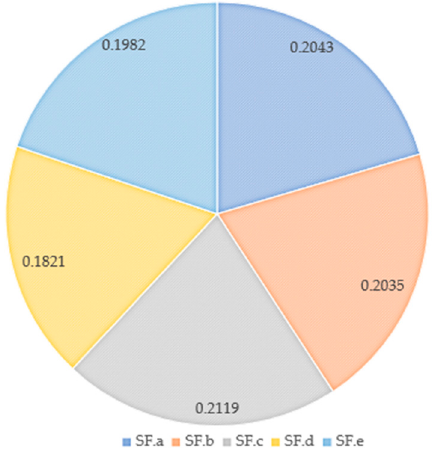
Figure 4. Local priorities of the KT